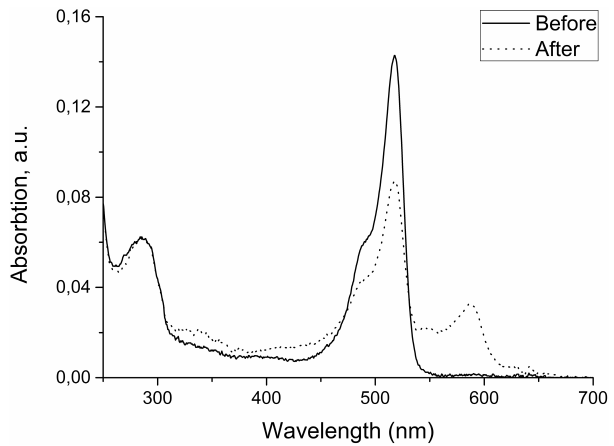
Fig. 4. Absorption of SAASoti before and after sunlight exposure.